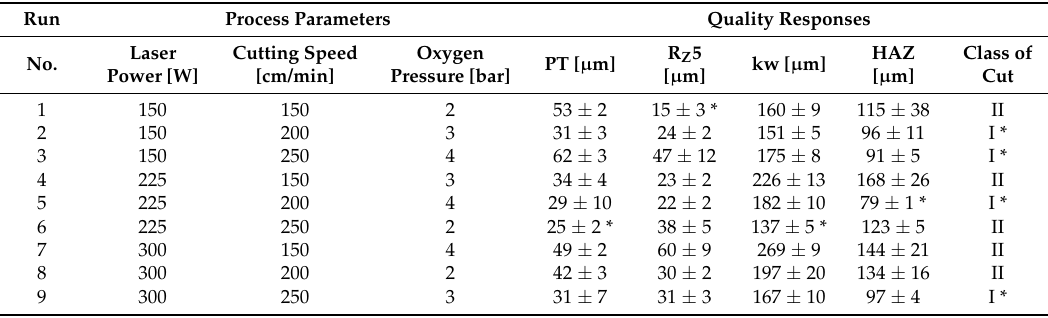
Table 3. Cut quality responses: average values and standard deviation. PT: perpendicularity tolerance; R Z 5: mean height of the surface profile; kw: top kerf width. Asterisks (*) highlight the best performances for each quality